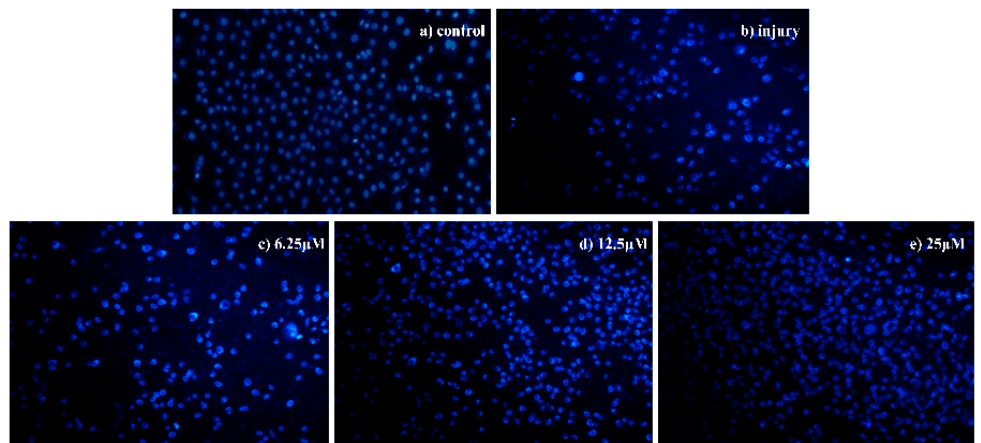
Figure 3. Morphological detection of apoptosis using 4 ′ ,6-diamidino-2-phenylindole (DAPI) staining (200 × ) on injured SH-SY5Y cells treated with compound 8 , ( a ) control group, ( b ) injury group, ( c ) 6.25 μ M, ( d ) 12.5 μ M, and ( e ) 25 μ M.